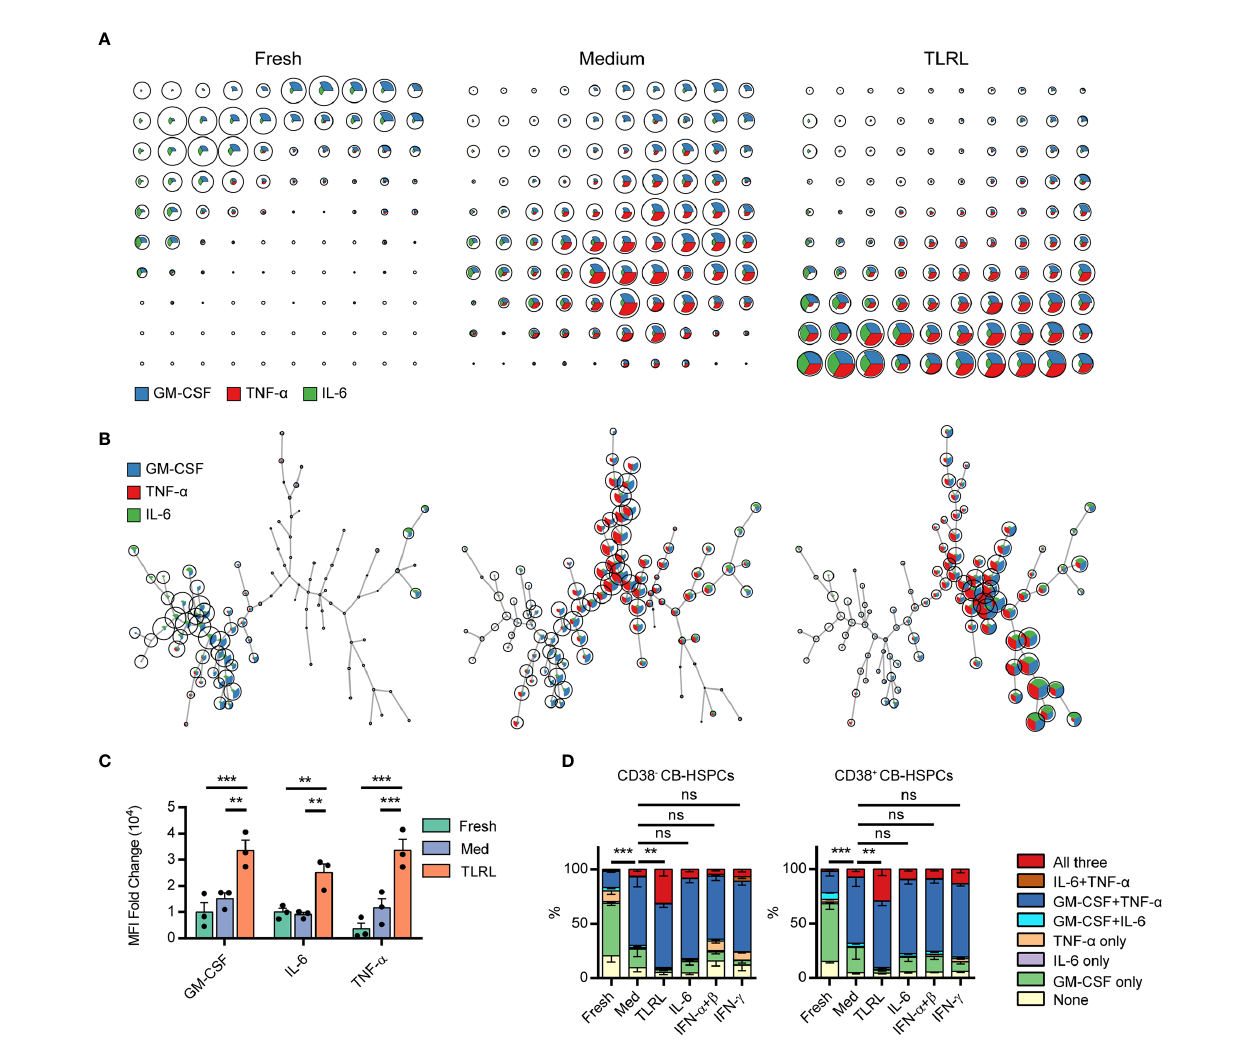
FIGURE 5 | Polyfunctional cytokine production capability of human CD34 + cells. (A, B) FlowSOM was used to train a self-organizing map (SOM) for cytokine staining in freshly isolated, cultured without stimulation, and TLRL-stimulated CB-derived CD34 + cells. The SOM results are shown on grids (A) or on minimal spanning trees (B) . Each cell was classi fi ed to the nearest node, which is coded as a pie chart with information about the expression of the three cytokines. The size of the nodes is relative to the percentage of cells presented in each cluster. Each node is represented by a star chart indicating the relative mean fl uorescence intensity values of each cytokine; the height of each sector indicates the intensity; if the part reaches the border of the circle, the cells have maximal expression for that cytokine. (C) MFI values of each cytokine in freshly isolated, cultured without stimulation, and TLRL-stimulated CB-derived CD34 + cells. The data refer to a typical experiment out of three that generated similar results. Data are shown as the mean ± SEM. ** P < 0.01 and *** P < 0.001, by 2-way ANOVA followed by Tukey ’ s test. (D) Polyfunctionality of CB-HSPCs stimulated for 12 h with various stimuli. The data refer to a typical experiment out of three that generated similar results. Data are shown as the mean ± SEM. ** P < 0.01, *** P < 0.001; ns, not signi fi cant, by a two-way ANOVA with